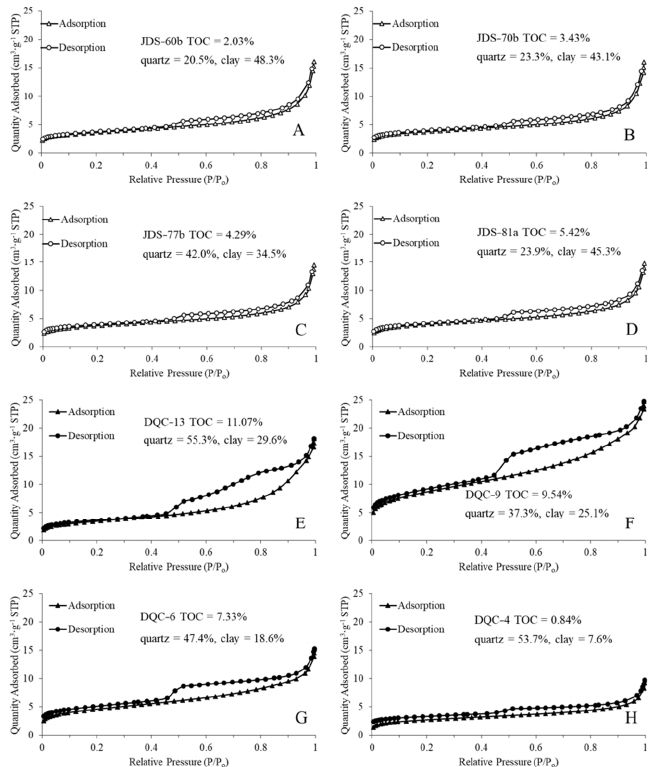
Figure 7. Nitrogen gas adsorption and desorption isotherms of the Niutitang shale. ( A – D ) H3 type of loop indicates the narrow slit-shaped pores of the Niutitang shale samples from the JDS-1 well. ( E – G ) H2 type loop indicates the ink-bottle-shaped pores of the Niutitang shale samples from the Danquancun section. ( H ) H3 type loop indicates the narrow slit-shaped pores of the Niutitang chert sample from the Danquancun section.